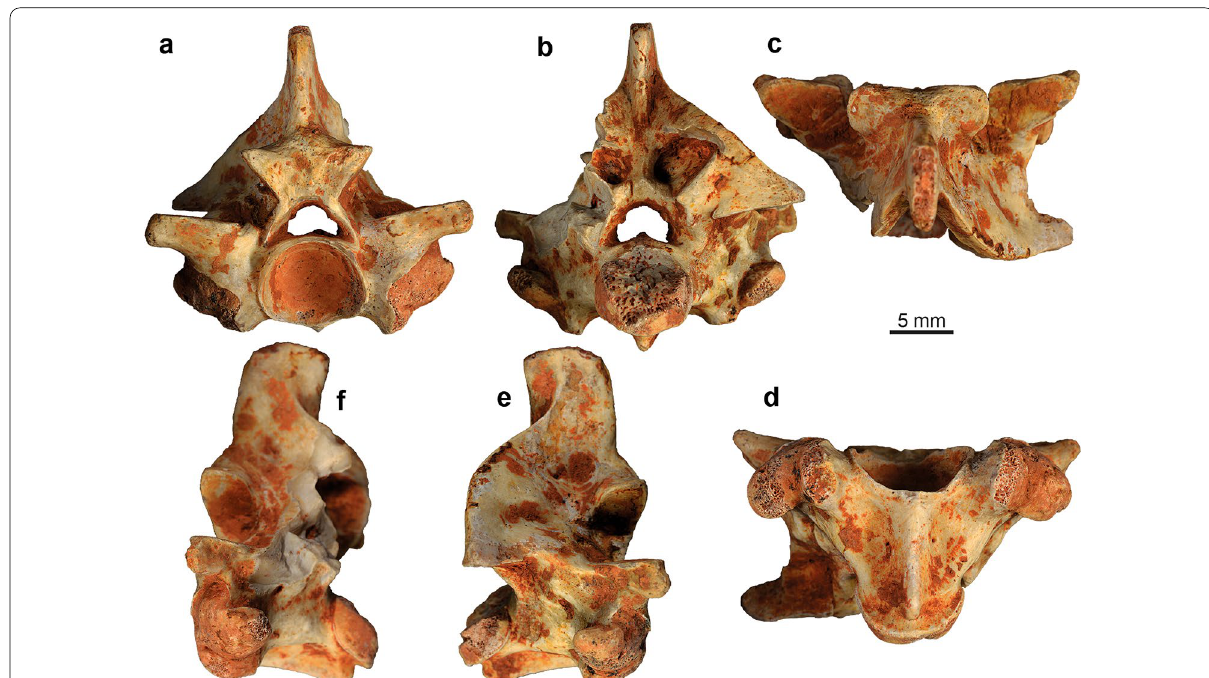
Fig. 17 Palaeopython cf. cadurcensis from an imprecisely known locality in the Phosphorites du Quercy: mid-trunk vertebra (NHMW 2019/0032/0001) in anterior ( a ), posterior ( b ), dorsal ( c ), ventral ( d ), right lateral ( e ), and left lateral ( f )